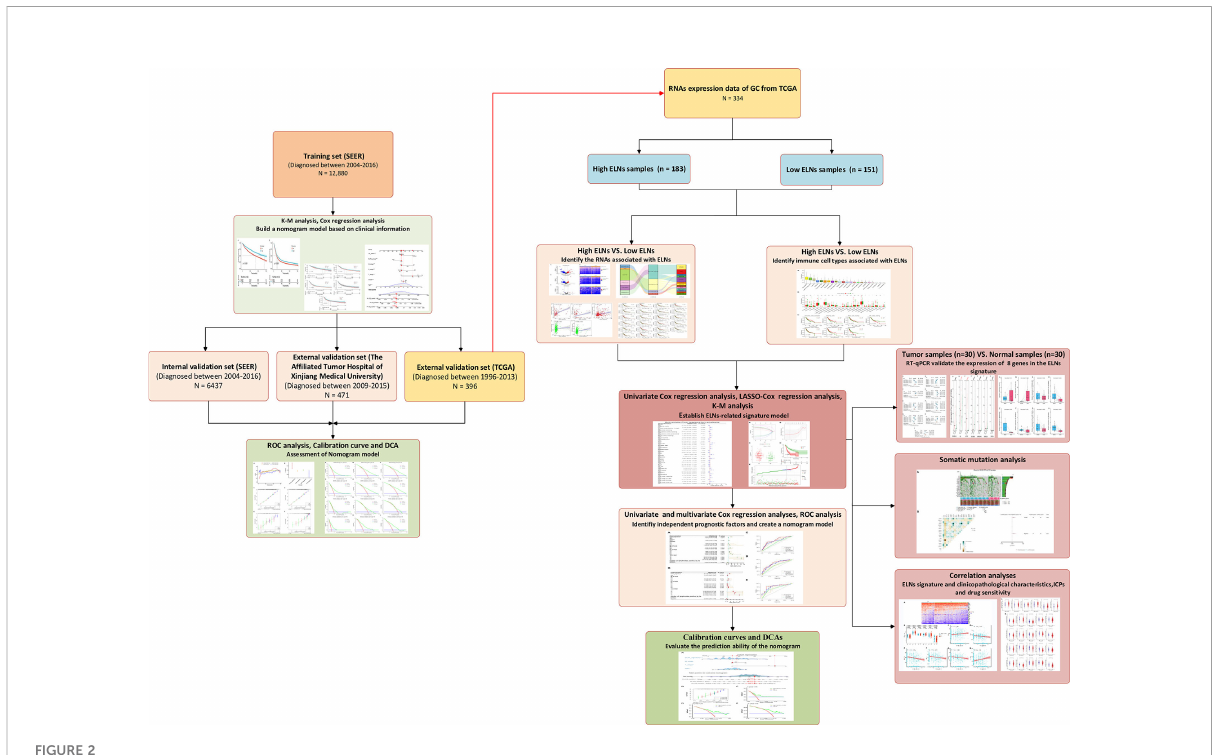
FIGURE 2 Flowchart of data analysis and